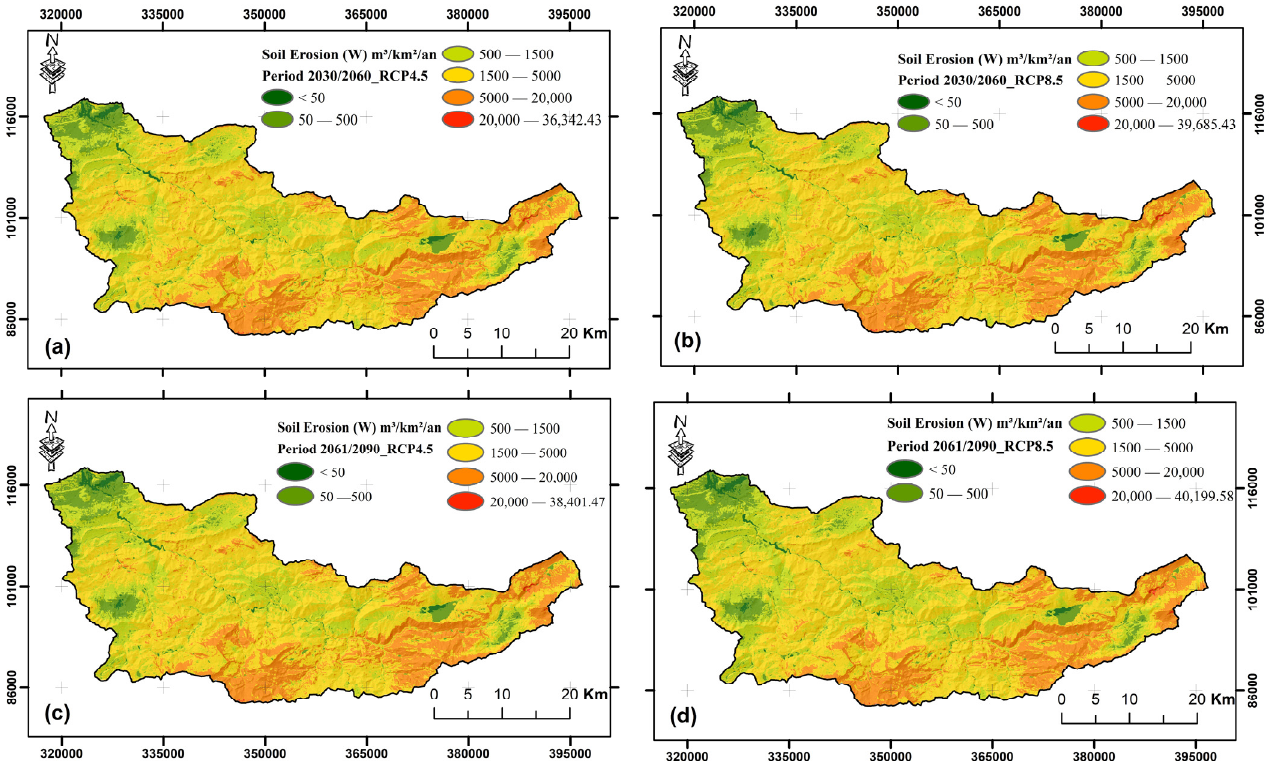
Figure 11. Maps of average annual soil erosion (W) [m 3 /year/km 2 ] considering future scenarios RCP4.5, RCP8.5, and using the EPM model. ( a ) period 2030–2060 RCP4.5, ( b ) period 2030–2060 RCP8.5, ( c ) period 2061–2090 RCP4.5, ( d ) period 2061–2090 RCP8.5.